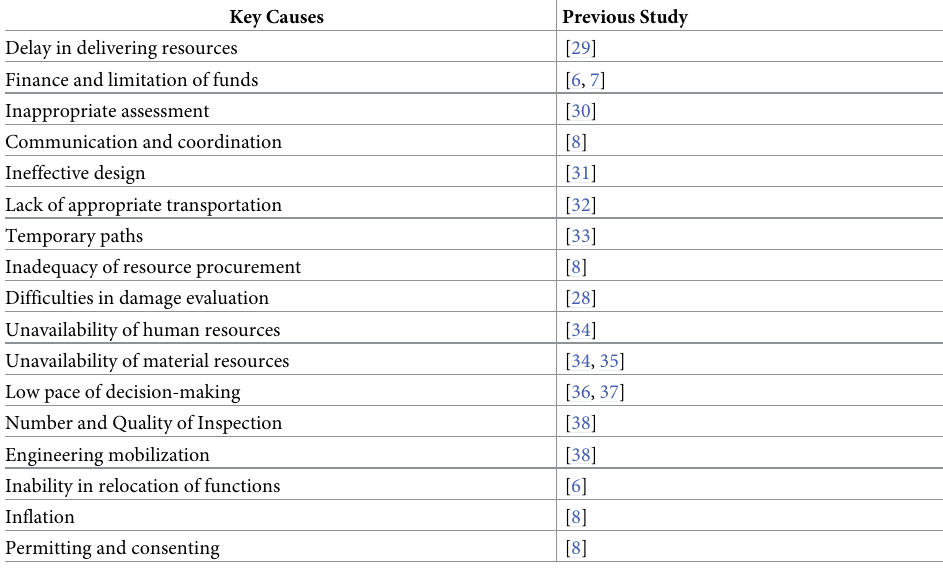
Table 1. Main causes of reconstruction failures after disasters. Key